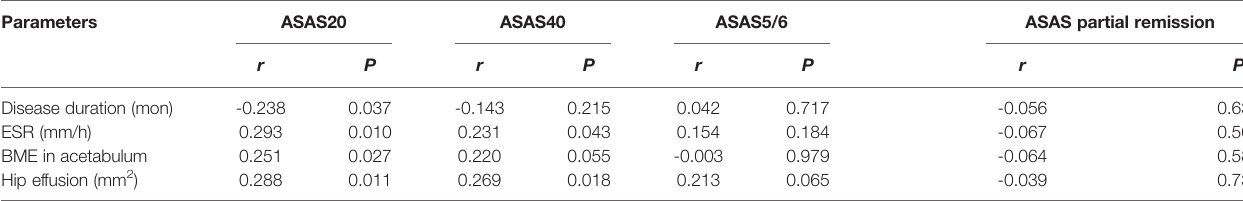
TABLE 4 | Results of indicators signi fi cantly correlated with treatment response. Parameters